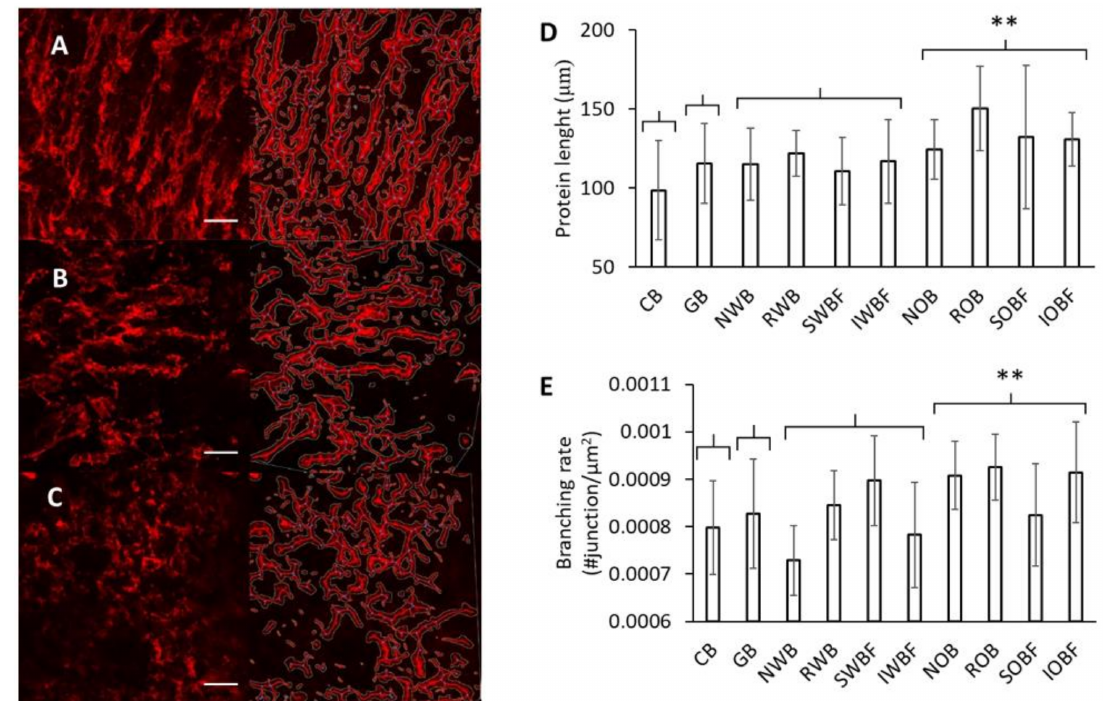
Figure 5. Examples of gluten microstructure visualized for the control dough ( A ) NWB-enriched dough ( B ) and NOB- enriched dough ( C ). The resulting analysis of the image using the Angiotool software is shown on the right for each sample. Protein length ( D ) and branching rate ( E ) as determined for all dough samples using the Angiotool. The symbol (**) indicates a significant ( p < 0.05) effect of the bran source. The white scale bar in ( A – C ) indicates 100 µ m. Sample abbreviations are reported in Table